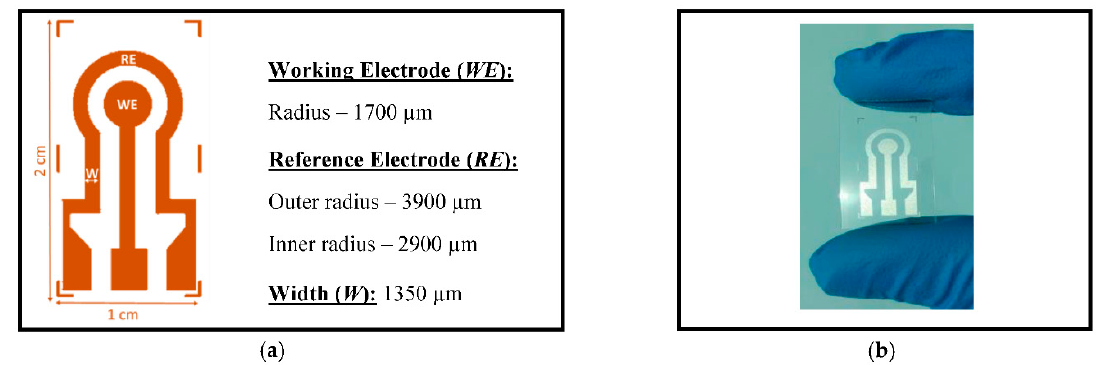
Figure 1. ( a ) Schematic of the electrochemical sensor; ( b ) Gravure printed flexible electrochemical